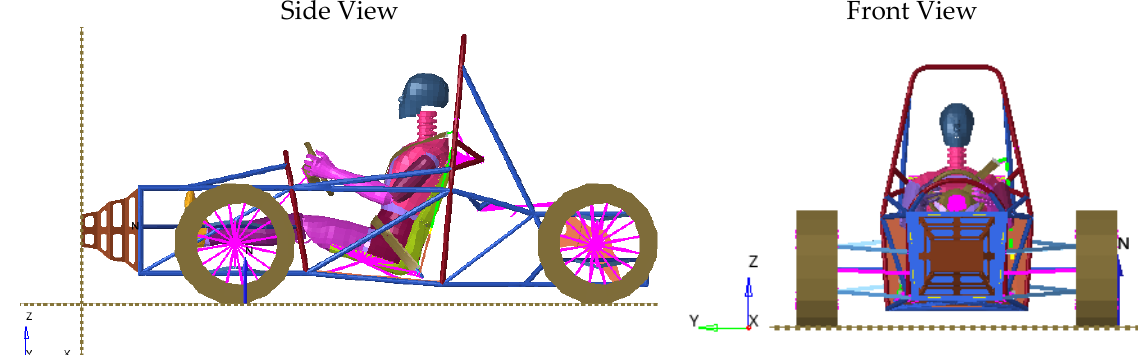
Figure 2. The car with a shock absorber and a seat belt. Side and front view.